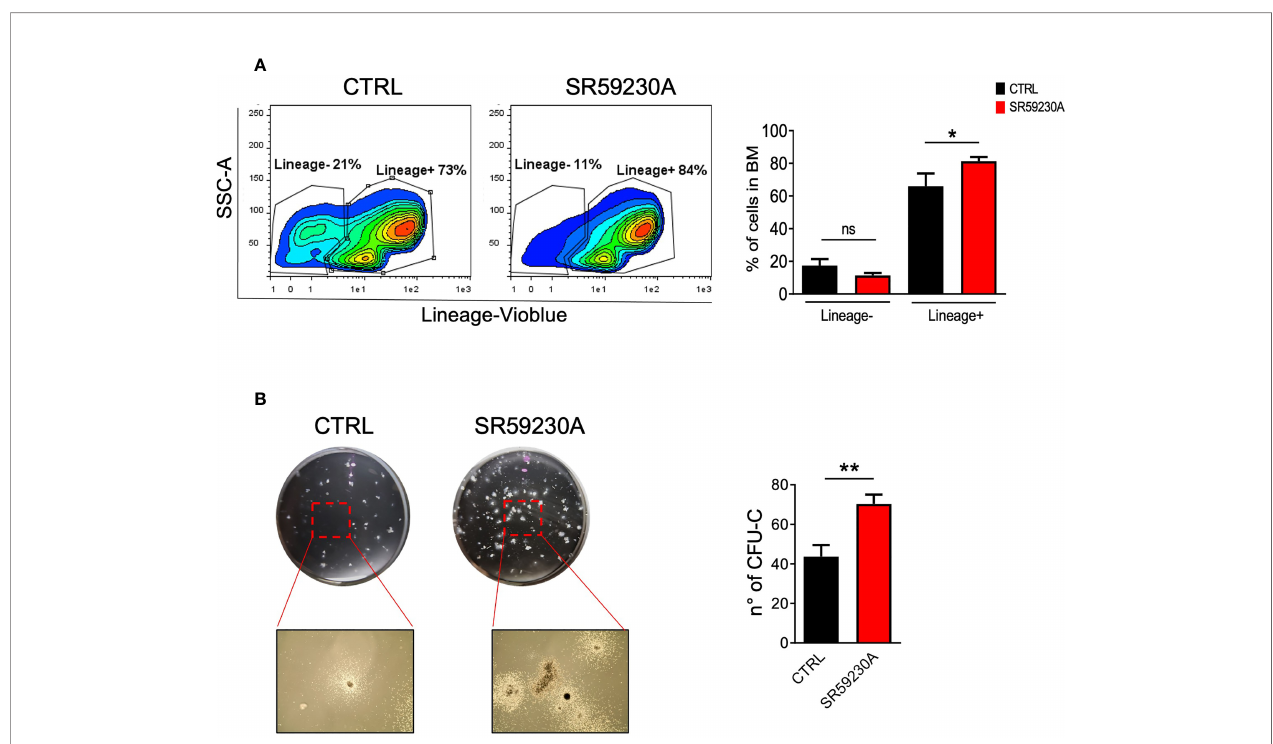
FIGURE 3 | Study of the b 3-AR antagonism effect on mouse BM cells ( in vivo model as in Figure 1A ). (A) Flow cytometry analysis of BM cells was performed by using MACSQuant Analyzer 10 (Miltenyi Bio-tec, Gladbach, Germany). Cells were stained with the Lineage cell detection cocktail and anti-biotin antibody. Results were reported as percentage (mean±SD of three replicates) of Lineage-positive or -negative cells. (B) Images showing colonies obtained by performing a CFU assay with a MethoCult medium (Stemcell Technologies, Vancouver, Canada) and relative quanti fi cation in SR59230A and control conditions after 10 days of culture. Results were reported as the mean ±SD of three replicates. *p <0,05 **p <0,01 SR59230A vs. CTRL. ns, non signi fi cant.